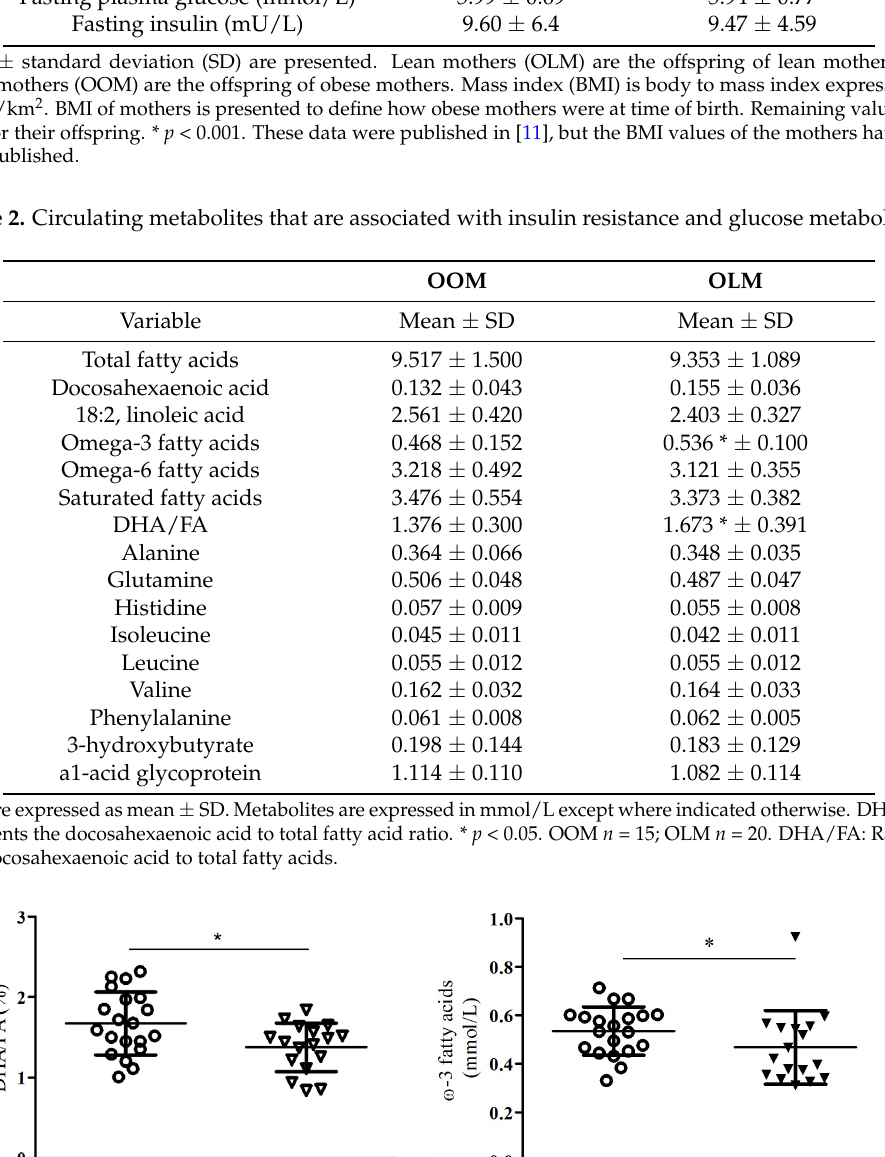
Table 1. Characteristics of study participants and of their mothers.